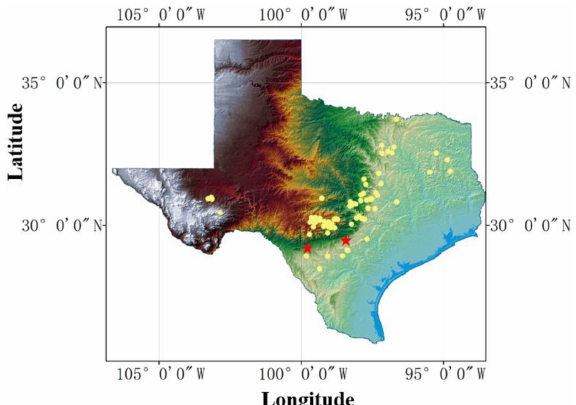
Figure A1. Spatial distribution of the confined aquifer wells in Texas, USA reported by Water Data for Texas. The two red stars denote the locations of the wells that have the first- and second- longest records; yellow solid circles denote the locations of the other 75 wells.